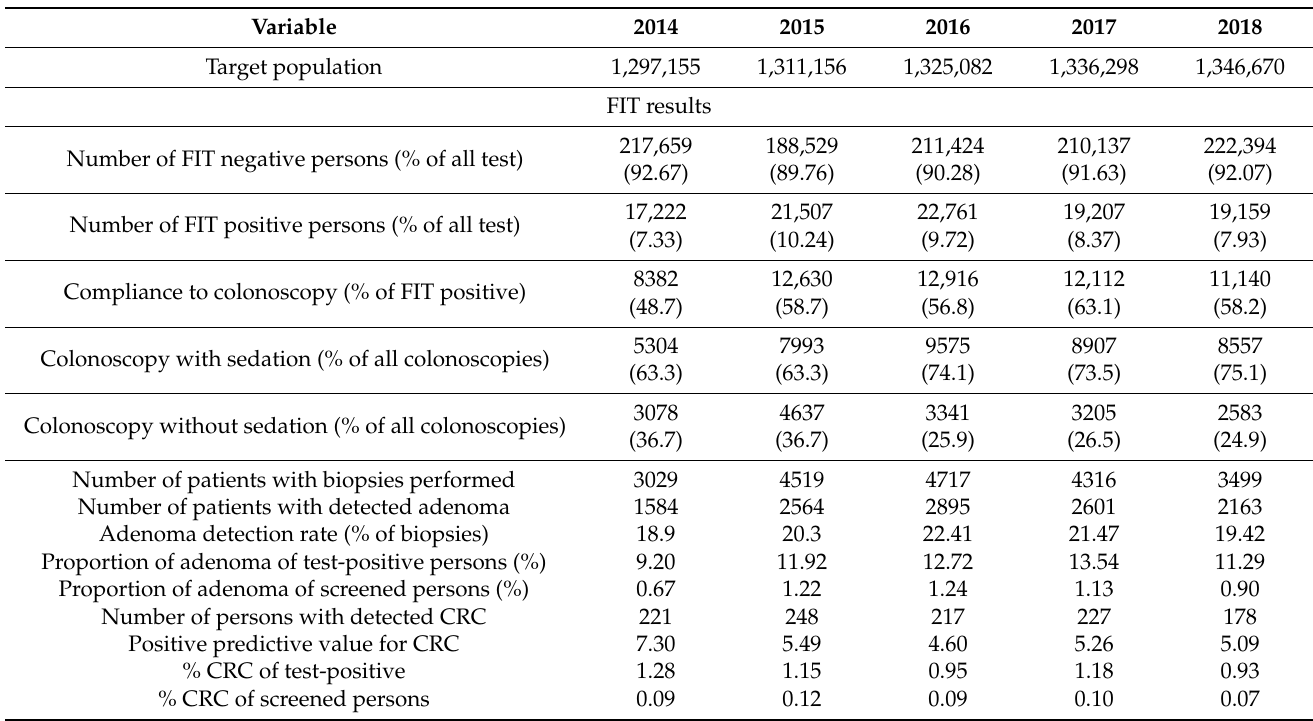
Table 2. Performance indicators for FIT and colonoscopy and outcomes of colorectal cancer screening program in Lithuania between 2014 and 2018.